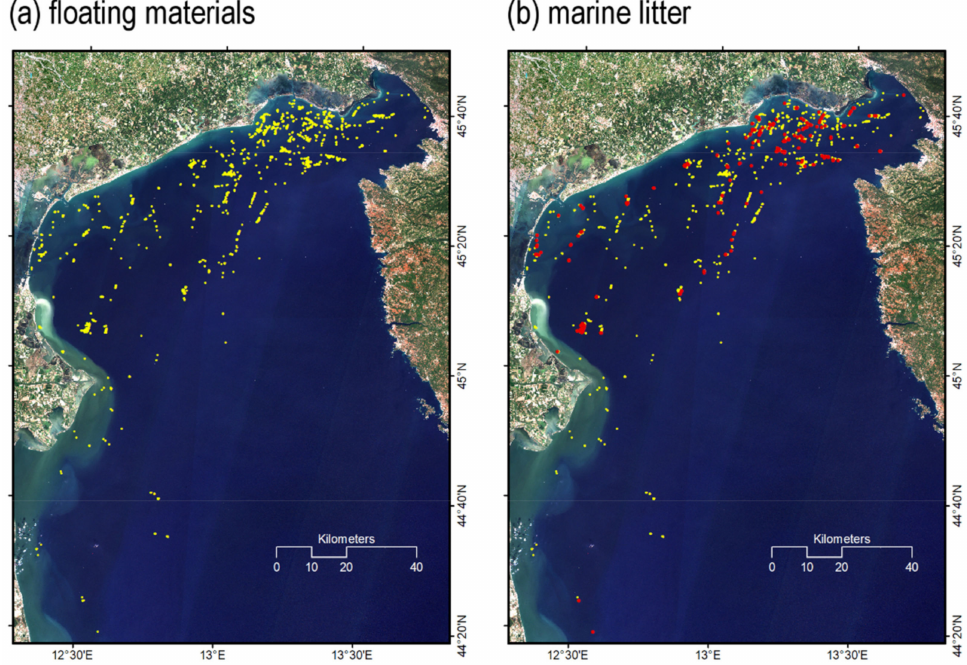
Figure 8. ( a ) Spatial distribution of the detected patches (including ‘unclassified’ pixels) on 6 dates of August 2020. ( b ) Spatial distribution of marine litter superimposed in red. The patches were enlarged to be visible at this scale. The maps indicate where floating matter was more frequently detected and not the total amount, because the same floating materials moved from one date to the